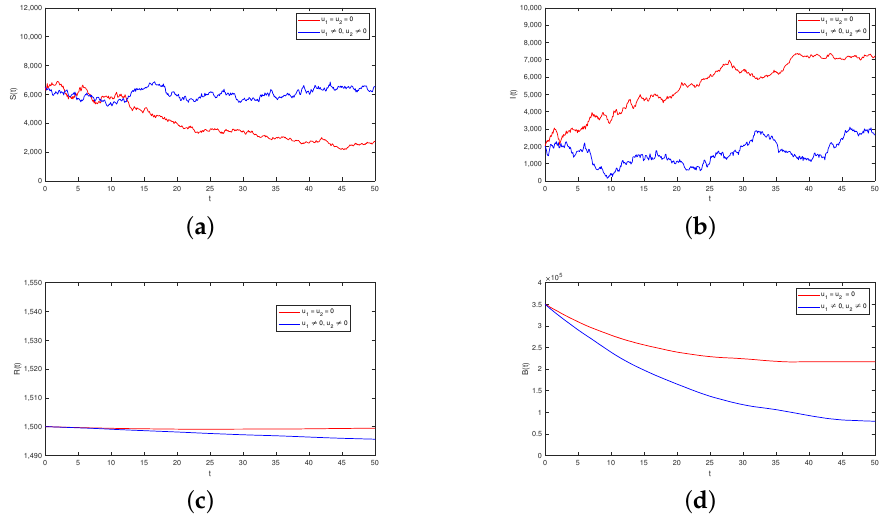
Figure 5. The plot represents (cid:83) ( t ) , (cid:73) ( t ) , (cid:82) ( t ) and (cid:66) ( t ) with and without control. ( a ) (cid:83) ( t ) -with and without control in case of stochastic model. ( b ) (cid:73) ( t ) -with and without control in case of stochastic model. ( c ) (cid:82) ( t ) -with and without control in case of stochastic model. ( d ) (cid:66) ( t ) -with and without control in case of stochastic